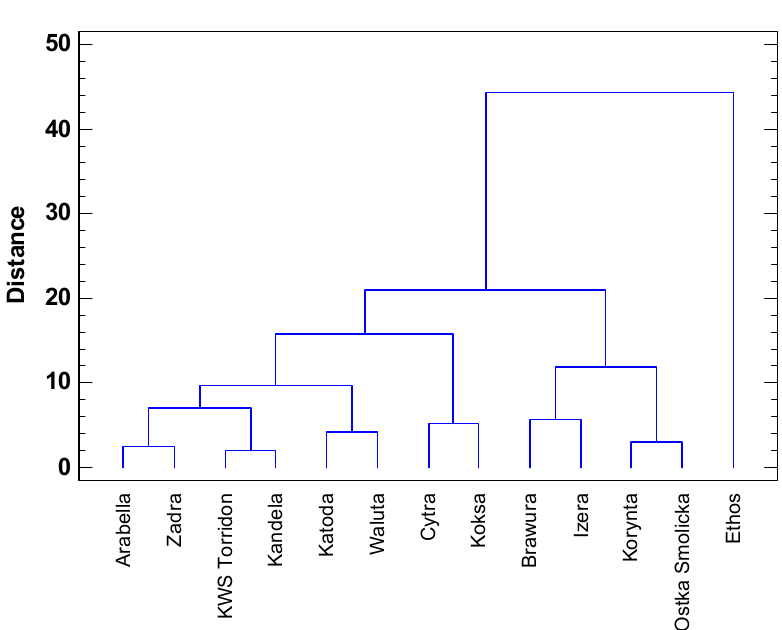
Figure 2. Dendrogram showing the similarity of spring wheat varieties.